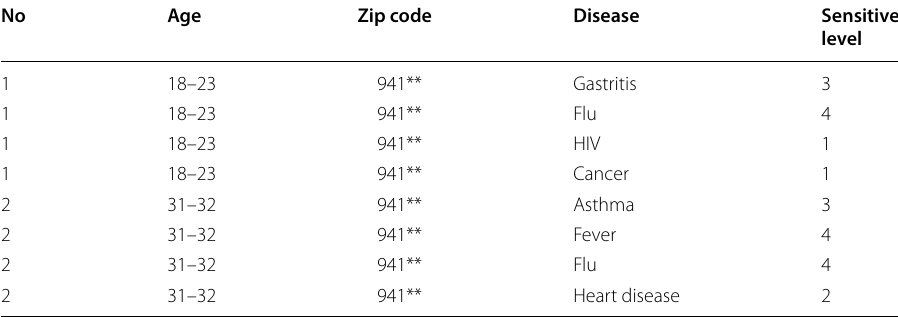
Table 7 Table after 2-level